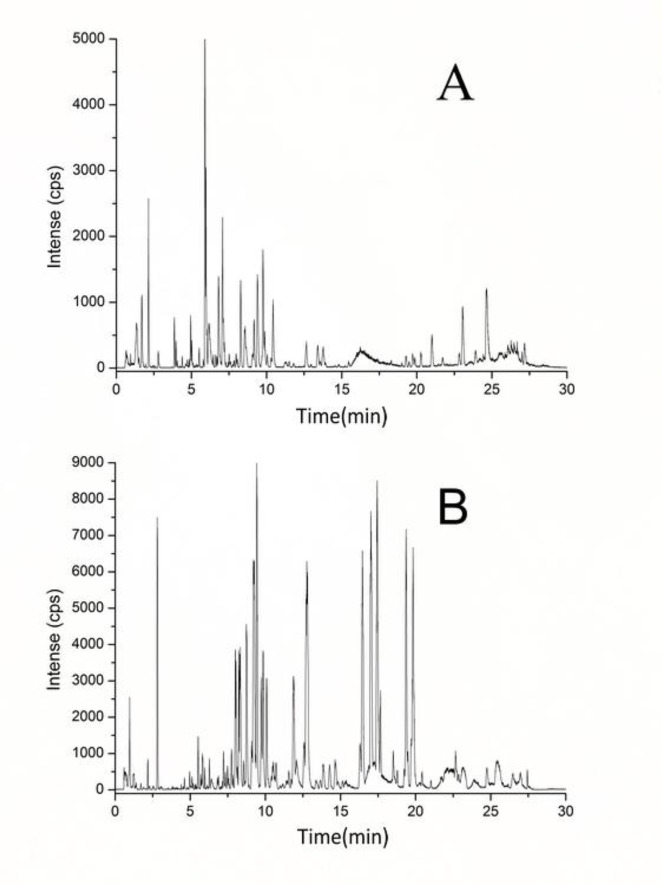
Representative base peak intensity chromatogram of rat serum obtained in the electrospray ionization (ESI) positive-ion (A) and negative-ion (B) V modes based on ultra performance liquid chromatography/quadrupole time-of-flight mass spectrometry (UPLC/Q-TOF-MS).